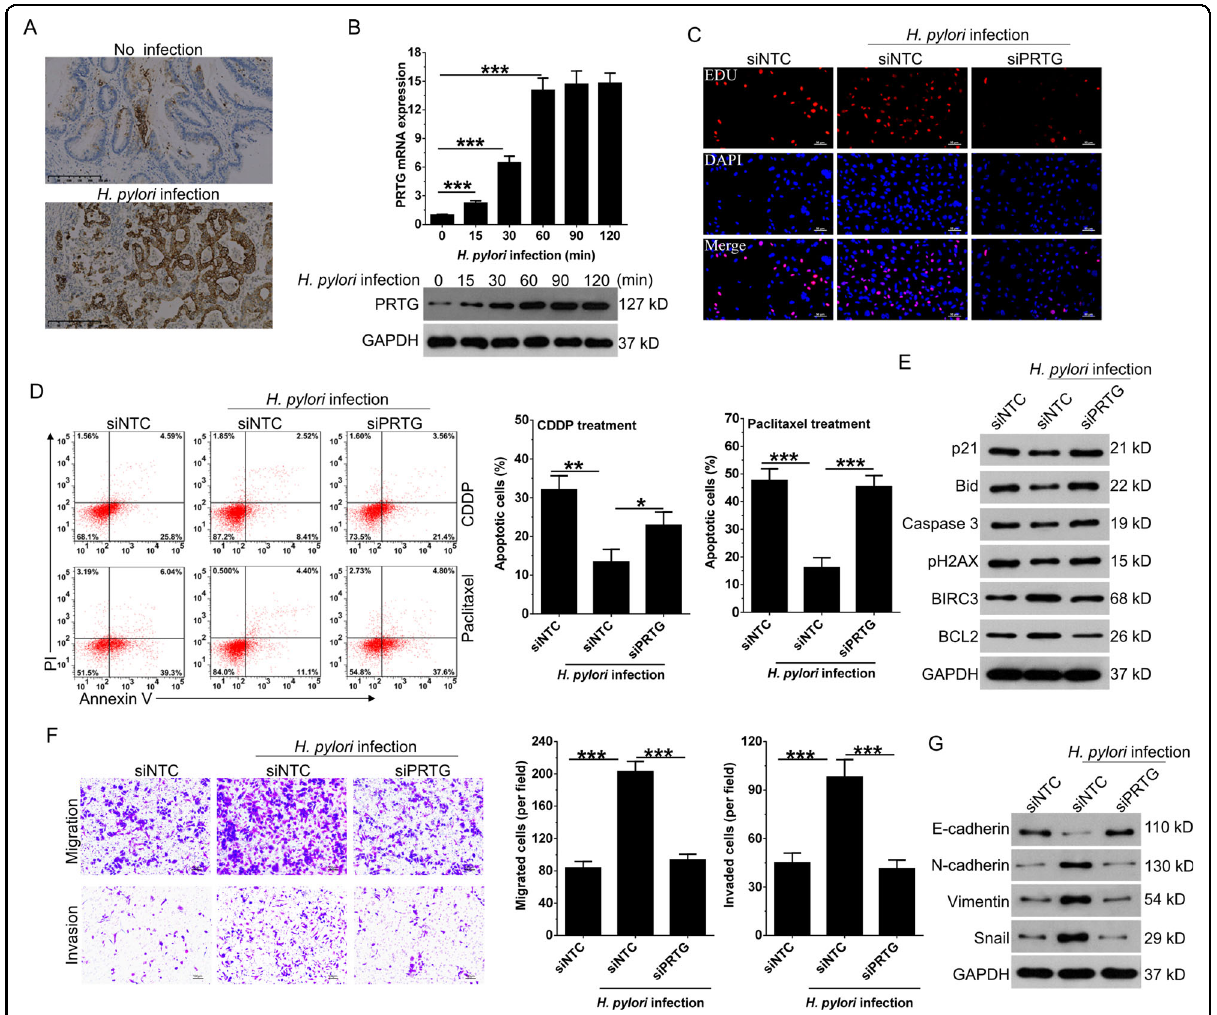
Fig. 3 PRTG is required for H. pylori to promote GC progression. A IHC staining of PRTG expression in GC tissues collected from local hospital with or without H. pylori infection. B qRT-PCR and western blot analysis of PRTG in AGS cells at different time points post infection with H. pylori (MOI = 10:1). C EdU assay was used to detect the effect of H. pylori infection on the proliferation of AGS cells after silencing PRTG expression. D Cell apoptosis was detected in PRTG silencing AGS cells after treated with chemotherapy drugs (paclitaxel, 20 nM; CDDP, 5 μ M) and infected with H. pylori (MOI = 10:1) for 48 h. E Western blot analyses were employed to analyze the expression of apoptosis-related protein in PRTG silencing AGS cells after treated with the paclitaxel and H. pylori for 48 h. F Transwell assays were used to detect the invasion and migration ability of PRTG silencing AGS cells after infected with H. pylori for 48 h. G Western blot analyses were used to detect the expression of EMT markers in PRTG silencing AGS cells after infected with H. pylori for 48 h. Data were presented as mean ± SD from the three independent replicates. * P < 0.05; ** P < 0.01; *** P < 0.0001. CDDP, cisplatin; EMT, epithelial to mesenchymal transition; siNTC, non-target control